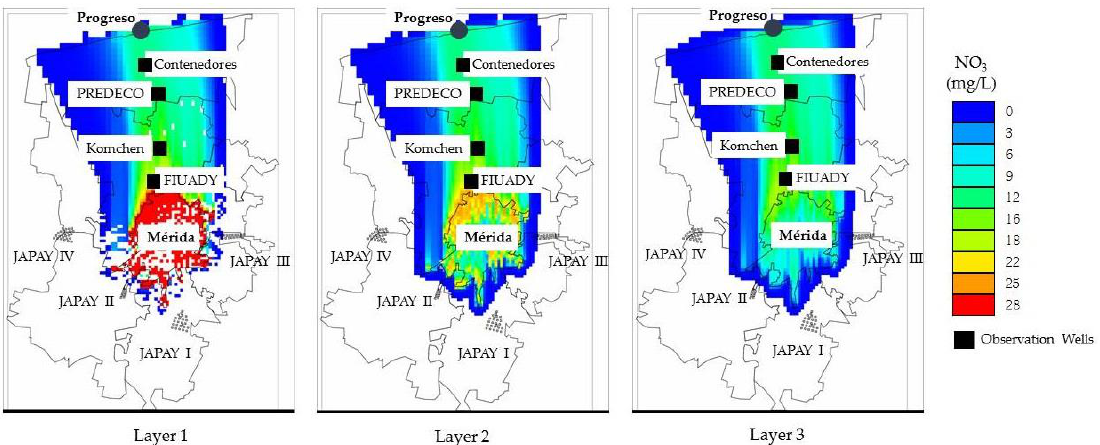
Figure 5. Particle tracking with Merida city as the particle release area. Two particles per axis were released for each grid corresponding to Merida City. A clear movement northward indicates the theoretical vulnerability of small communities between Merida and Progreso.